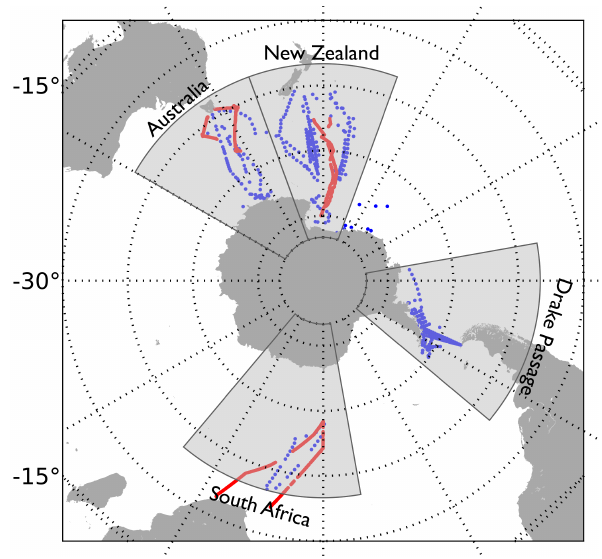
Figure 1. Map of O 2 observations used in the study. Grey shad- ings signifies the four regions we focus on in this study. Dots indi- cate discreet sampling locations, while red lines indicate continuous